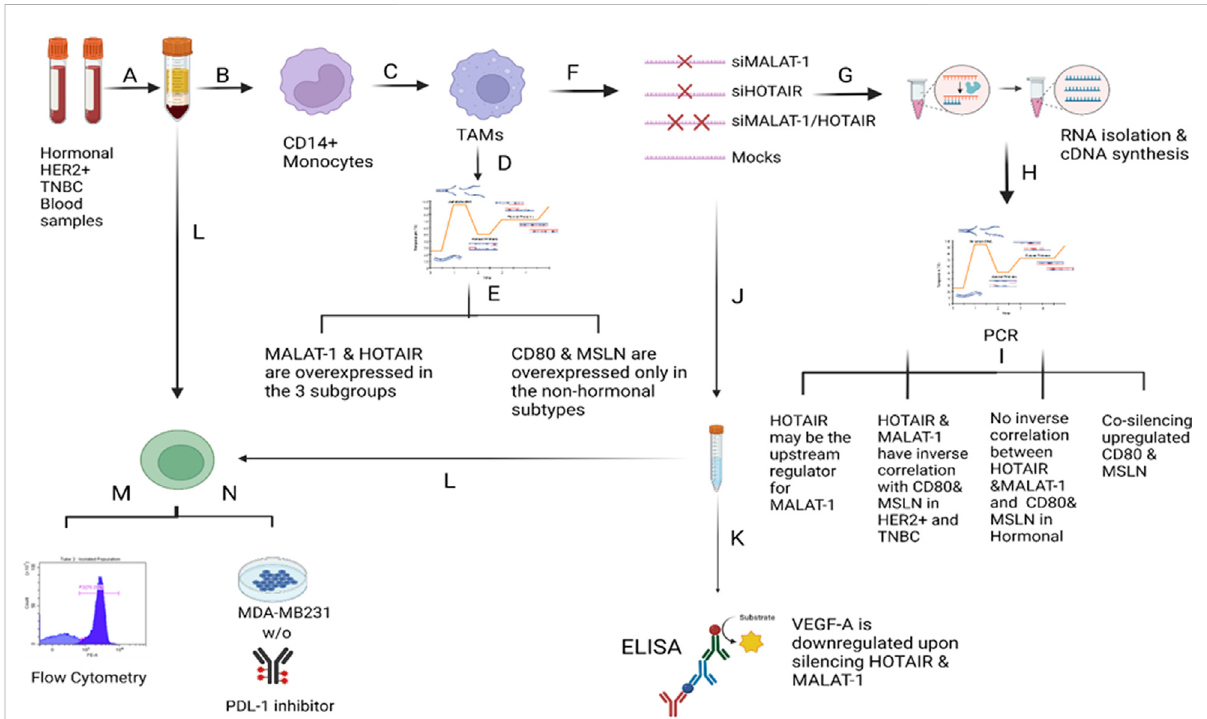
FIGURE 12 Overview of the methodology and results. A) Total PBMCs were isolated from fresh blood samples collected from BC patients (hormonal, HER2 + , and TNBC subtypes) using the Ficoll technique. B) CD14 + monocytes were isolated from the total PBMCs using the negative depletion method. C) CD14 + monocytes were cultured in the differentiation medium (IL-10, IL-4, M-CSF, and TCM) for 7 days. D) On the 7th day, TAMs were harvested and subjected to total RNA isolation, cDNA synthesis and PCR screening for MALAT1, HOTAIR, CD80, and MSLN. E) MALAT1 and HOTAIR were found to be overexpressed in the TAMs of the three subgroups proposing their potential to be oncogenic lncRNAs. CD80 and MSLN were found to be overexpressed only in HER2+ and TNBC TAMs, suggesting that estrogen can be the controlling factor for their expression in